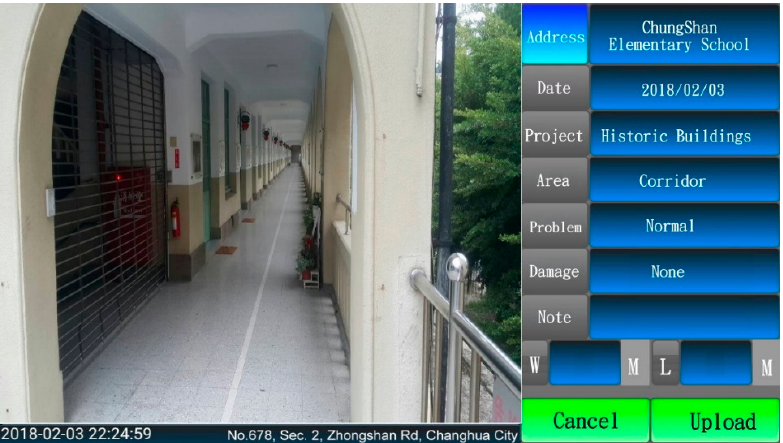
Figure 11. Automatic positioning and default information categories.